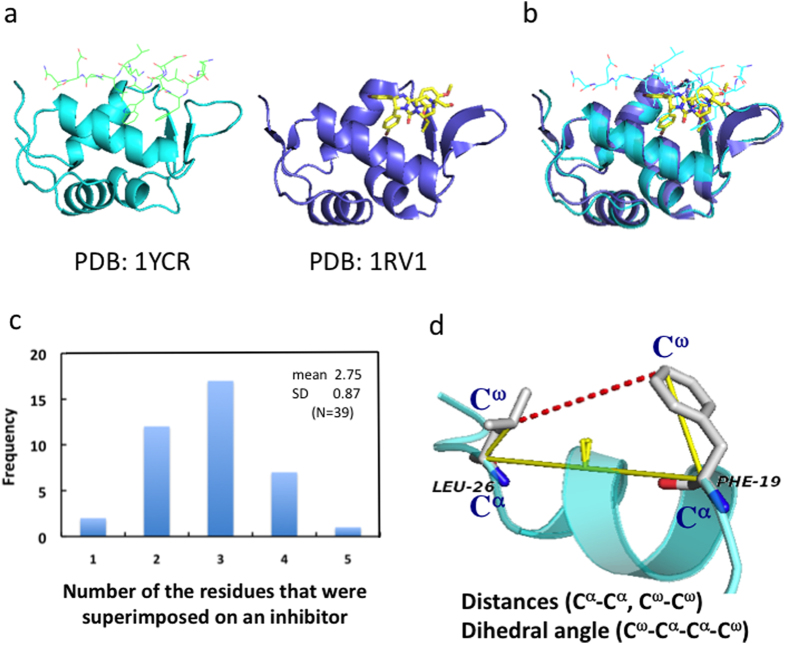
(a) Example of a protein-protein structure (pdb:1YCR) and protein-inhibitor structure (pdb:1RV1). (b) Example of computational alignment. The alignment between Mdm of the protein–protein complex (pdb:1YCR, green) and Mdm of the inhibitor–protein complex (pdb: 1RV1, purple) is shown. (c) The numerical distribution of residues that were superimposed onto an inhibitor. (d) Example of a method of measuring the structural data of the residue pairs. The distances of Cα – Cα and Cω – Cω were measured. The Cω – Cα – Cα – Cω dihedral angles of the residues are shown (pdb:1YCR). The structural figure was generated using PyMOL (http://www.pymol.org).